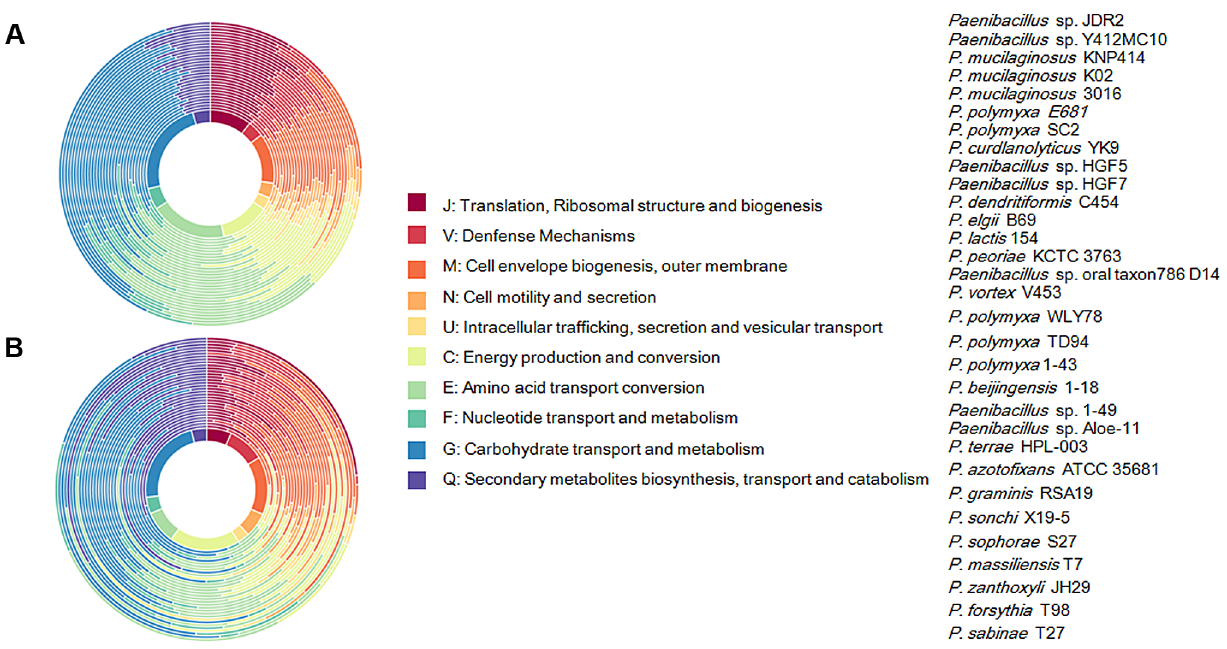
Figure 2. Functional classification of gene content of the 31 Paenibacillus strains. (A) Profiles of Cluster of Orthologous Groups (COG) showing percentage of genes in each category out of total annotated genes. Taxa from inside of circle to outside of circle are from Paenibacillus sp. JDR 2 (top in the strain list) to P. sabinae T27 (down in the strain list). (B) Profiles of COG showing function categories for genes in core genomes. Taxa from inside of circle to outside of circle are from Paenibacillus sp. JDR 2 (top in the strain list) to P. sabinae T27 (down in the strain list).